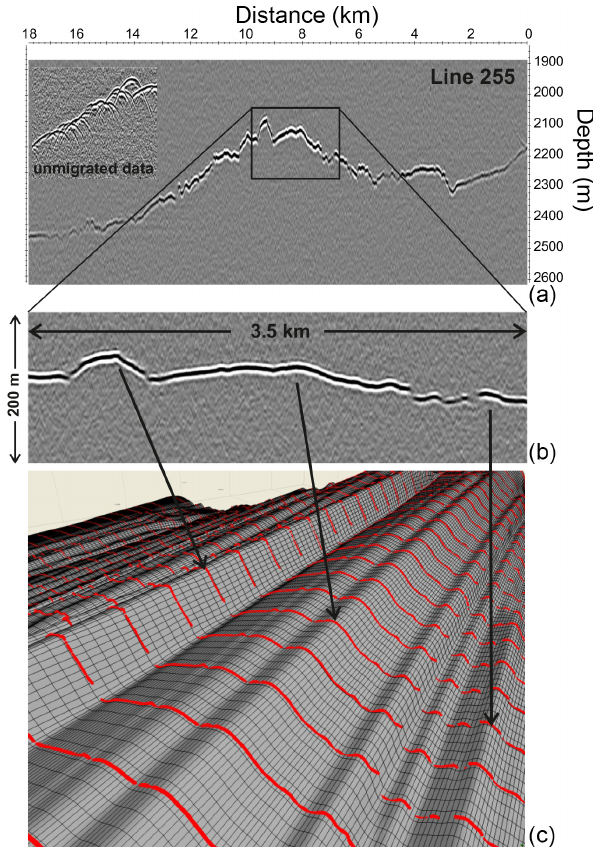
Figure 2. Detail of radar data. (a) Portion of radar profile across Rutford Ice Stream, windowed around the ice–sediment interface. Insert shows a portion of the data before the migration process- ing step. (b) Close-up of interface reflection. The reflection is a negative-positive-negative wavelet (white-black-white on the grey- scale record) with a very high signal-to-noise ratio which allows very precise determination of the travel time. (c) 3-D view of the data (red lines) and interpolated grid (black lines) which shows the coherence of the picked data from line to line and shows that the gridded data faithfully reproduce the observed